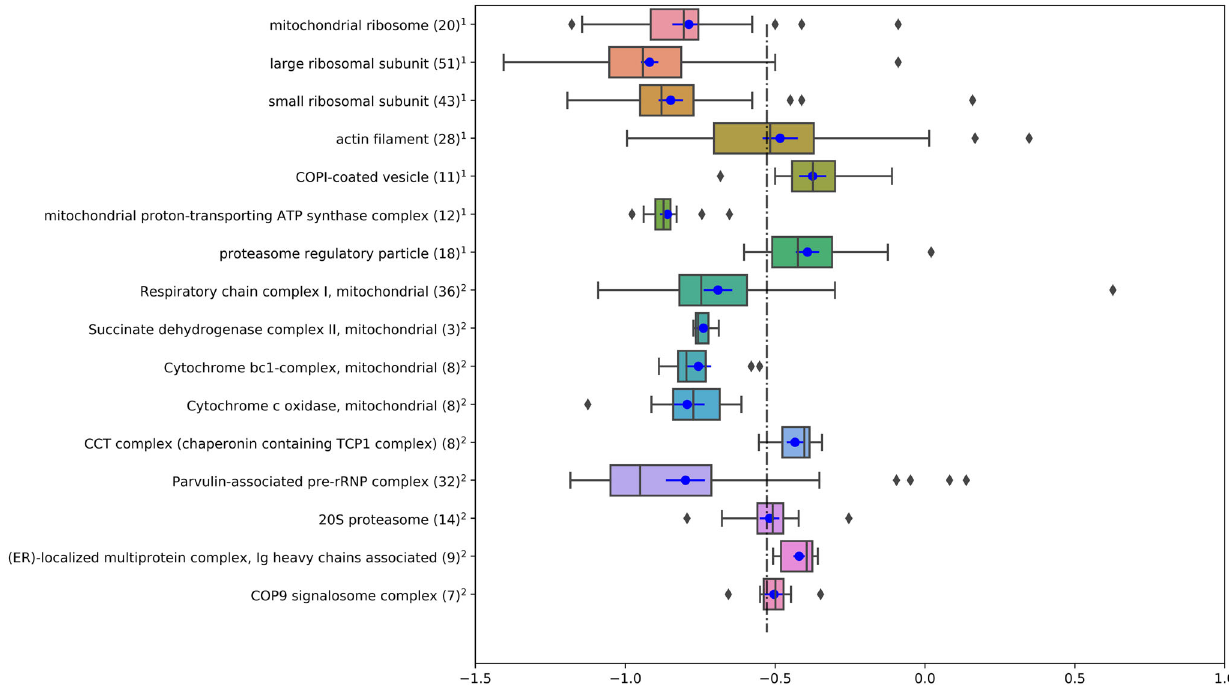
Fig. 7 Proteins of a complex have similar turnover rates. Turnover rates of proteins in protein complexes obtained from Gene Ontology and CORUM databases. x-axis is the base-10 logarithm of the protein turnover rates. Shown are the boxplots of turnover rates of proteins for each complex. Each box comprises turnover rates between the 25th and 75th percentiles of the complex proteins. The vertical bar in each box is the median turnover rate of the proteins in the corresponding complex. The blue dot in each box is the mean turnover rate of the proteins in the complex. The horizontal blue line indicates the standard error of the mean. The dashed vertical line is the median protein turnover rate in the liver sample. COPI coatomer complex, ATP adenosine triphosphate, ER endoplasmatic reticulum, rRNP ribosomal ribonucleoprotein, COP9 Constitutive photomorphogenesis 9. 1 — complexes obtained from the Gene Ontology database (cellular component). 2 — complexes obtained from the CORUM